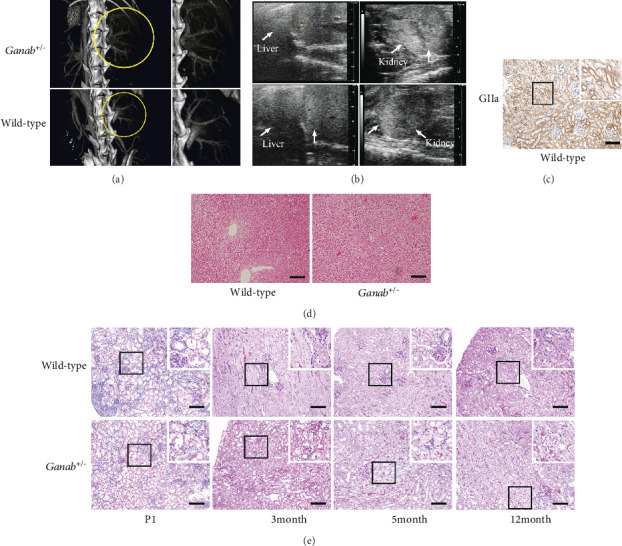
No kidney or liver cyst phenotypes were observed in Ganab+/- mice. (a) There were no obvious abnormalities in blood vessels and tissues of Ganab+/- mice via angiographic contrast-enhanced CT examination (n = 5). (b) No liver or kidney cysts were found in the Ganab+/- group by Doppler ultrasonography (n = 5 per group). (c) Immunohistochemical staining of wild-type kidney tissue with anti-GIIa antibody showed that GIIa was mainly distributed in the renal tubules. (d) H&E staining of liver tissues showed that no cysts were observed in the Ganab+/- or wild-type liver. (e) PAS staining of kidney tissues from P1 to 12 months showed that no obvious dilated tubules were observed in Ganab+/- and wild-type kidneys (n = 5). Scale bars: 100 μm.